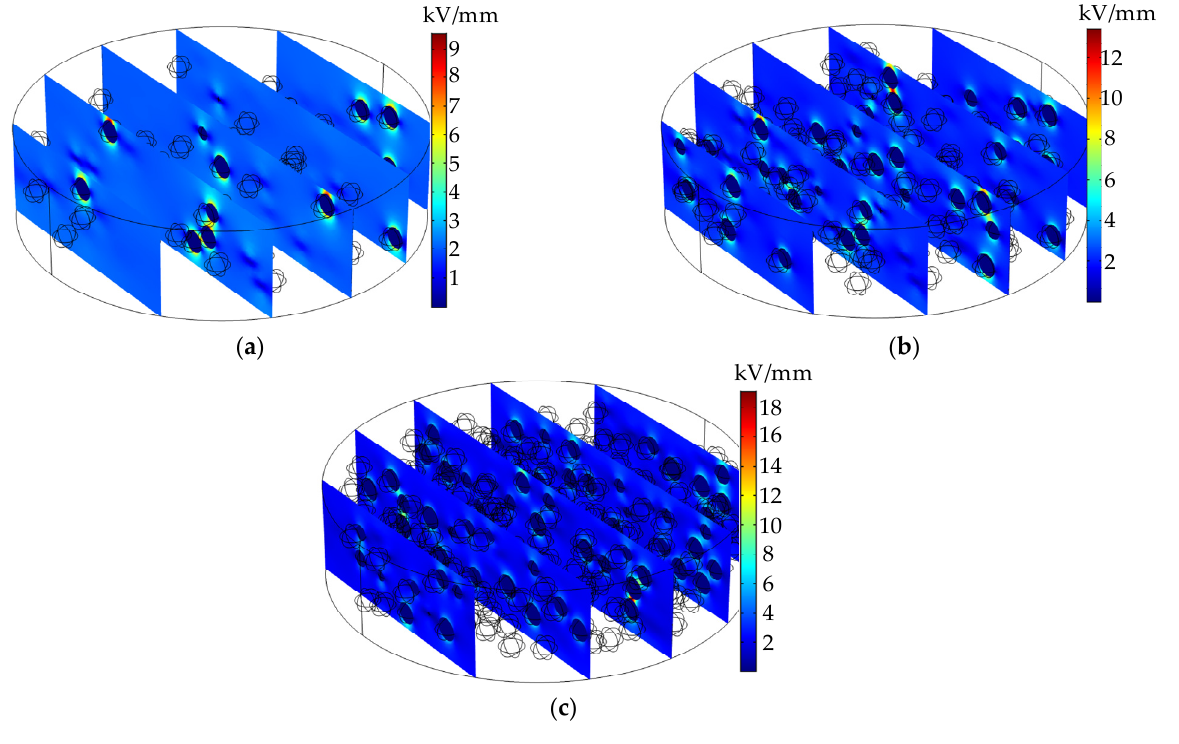
Figure 6. Cross-section of the electric field of the compound model under a constant electric field. ( a ) 10 wt% SiC; ( b ) 20 wt% SiC; ( c ) 30 wt% SiC.